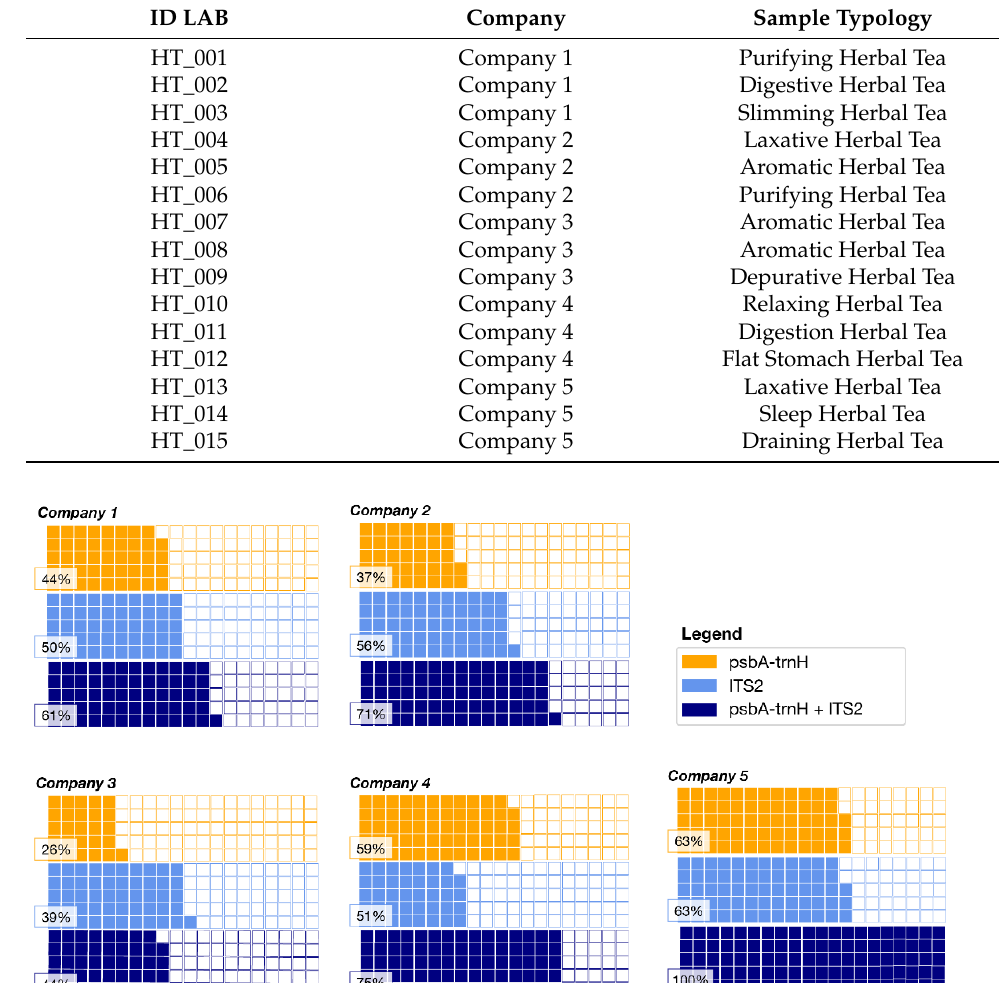
Table 2. The ID specimen for all samples, the company of production and the sample typology.